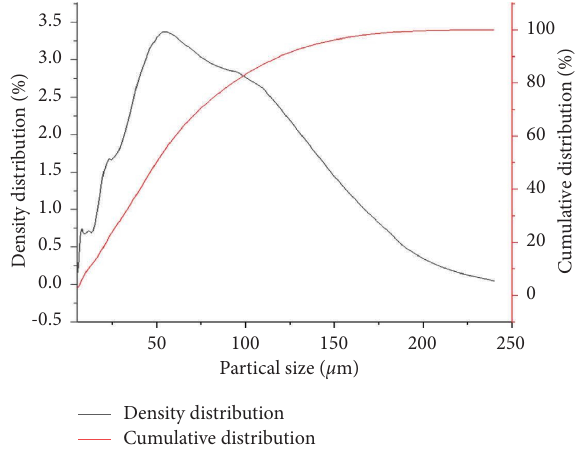
Figure 5: Particle size distribution (PSD) of optimized green banana